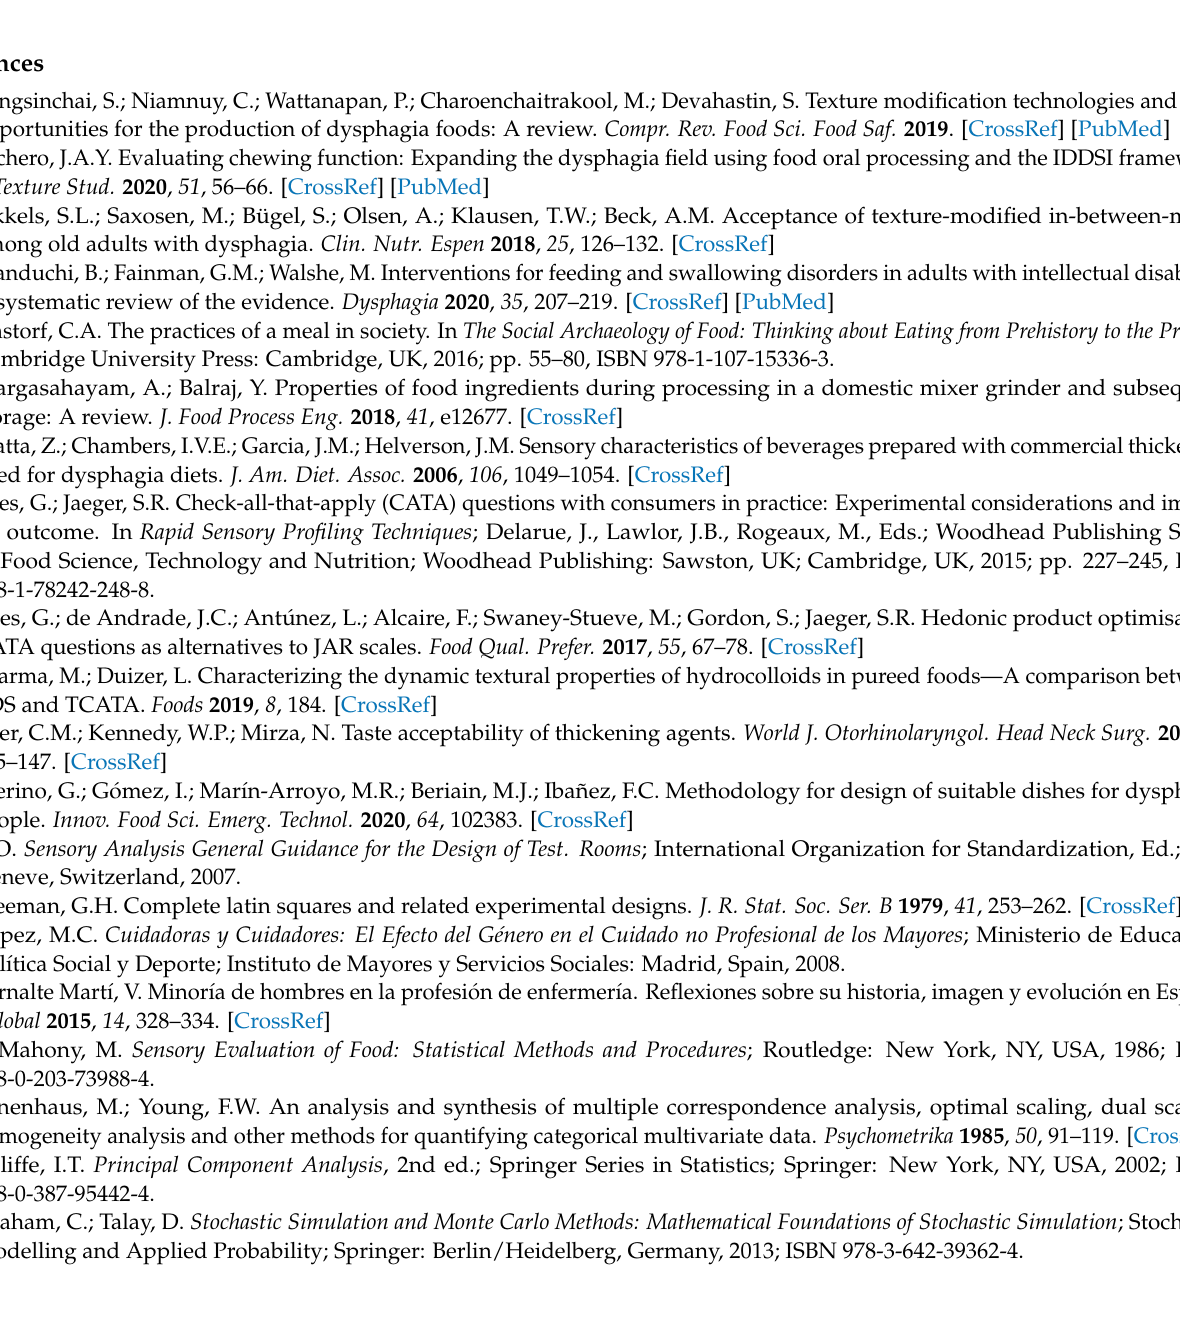
(i) (j) Figure A2. Percentages of identifications of the original dishes in the texture-modified dishes (left) and judges’ variety of answers for each texture-modified dish (right). The size of a word in the right-hand side visualization is proportional to the number of responses reported by the judges. Dishes: chickpea stew, CS ( a , b ); lentils with rice, LR ( c , d ); chicken stew, ChS ( e , f ); halibut with green sauce, H ( g , h ); and pasta bolognese, PB ( i , j ).